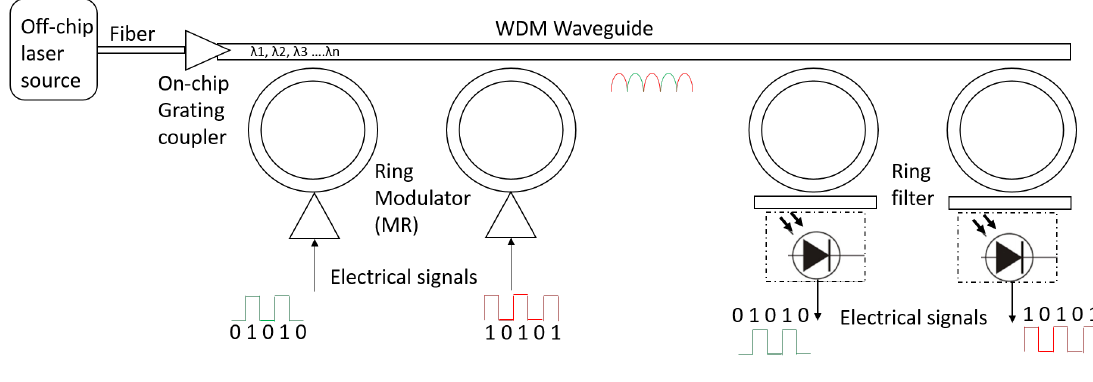
Figure 1. Photonic link